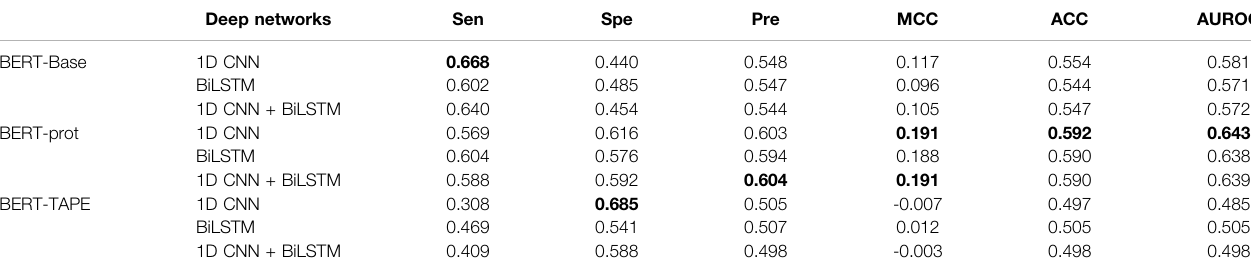
TABLE 1 | Cross-validation performance of models based on embeddings of token “ CLS ” extracted from different pretrained BERT models. Deep networks Sen Spe Pre MCC ACC AUROC BERT-Base